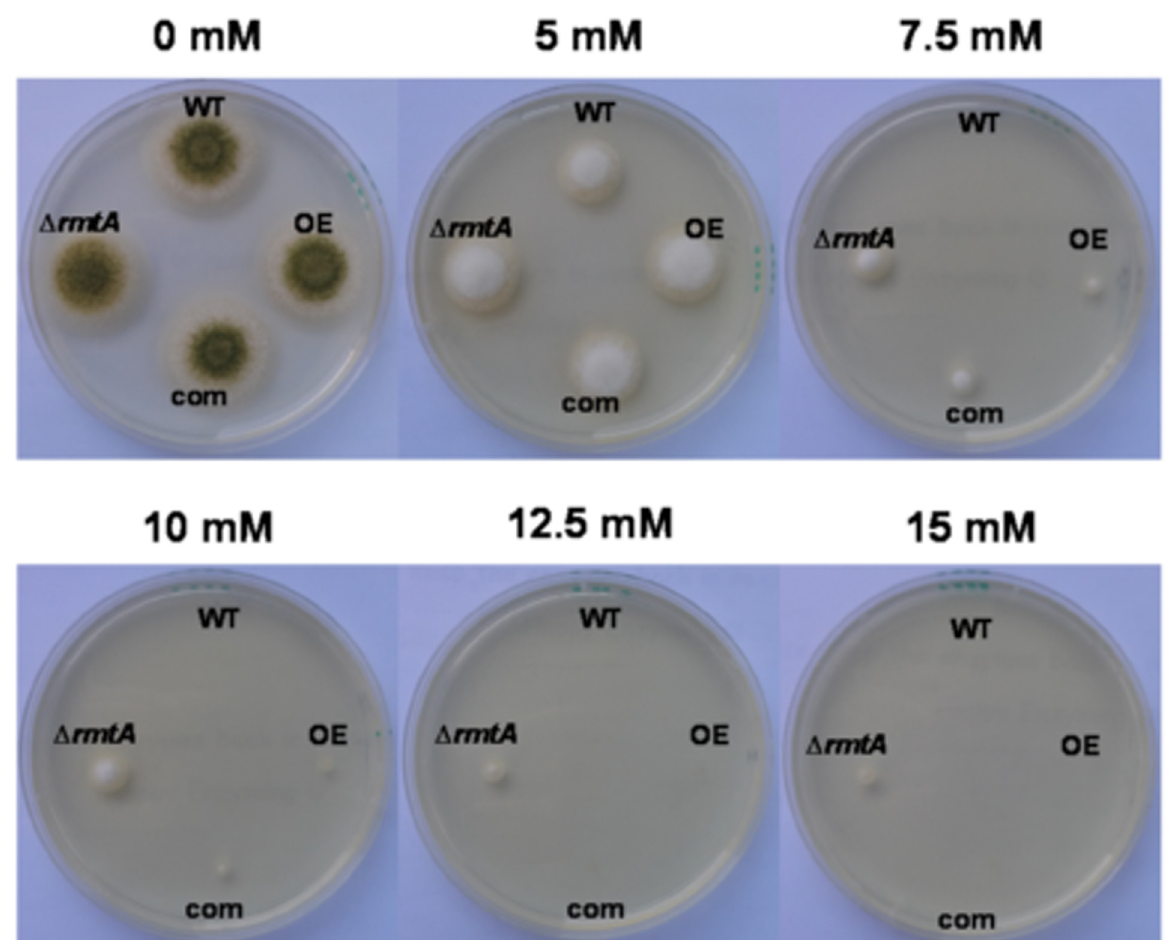
Fig 7. Role of rmtA in oxidative stress tolerance. A . flavus wild type (WT), Δ rmtA , complementation (com) and OE rmtA (OE) strains were point-inoculated on PDA containing a range of menadione concentrations (5 mM, 7.5 mM, 10 mM, 12.5 mM, and 15 mM). Cultures were incubated for 48 h at